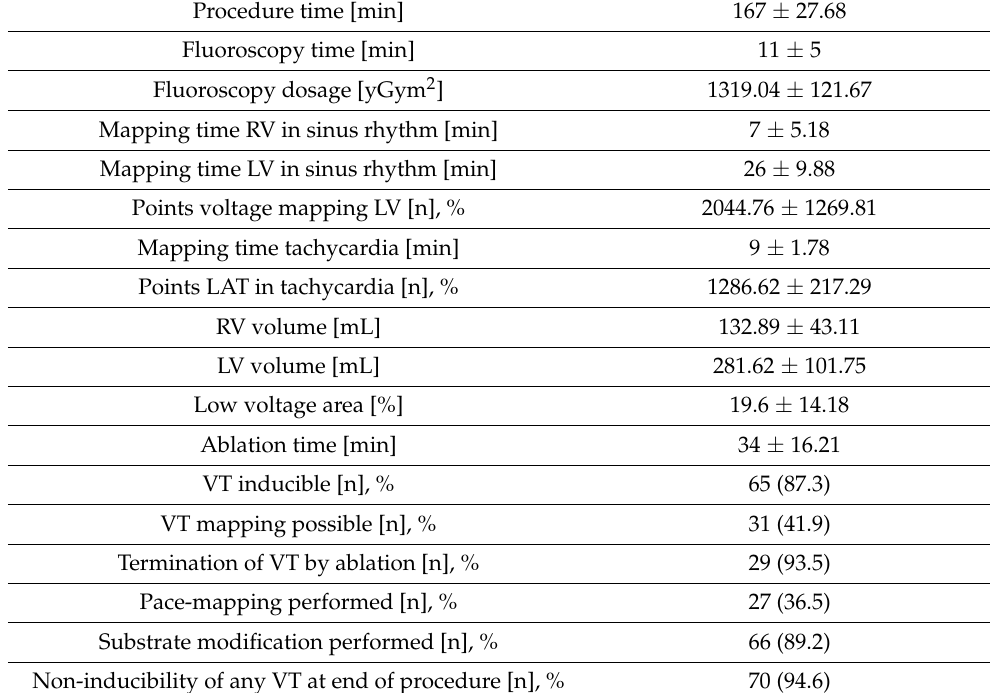
Table 2. Procedural data.